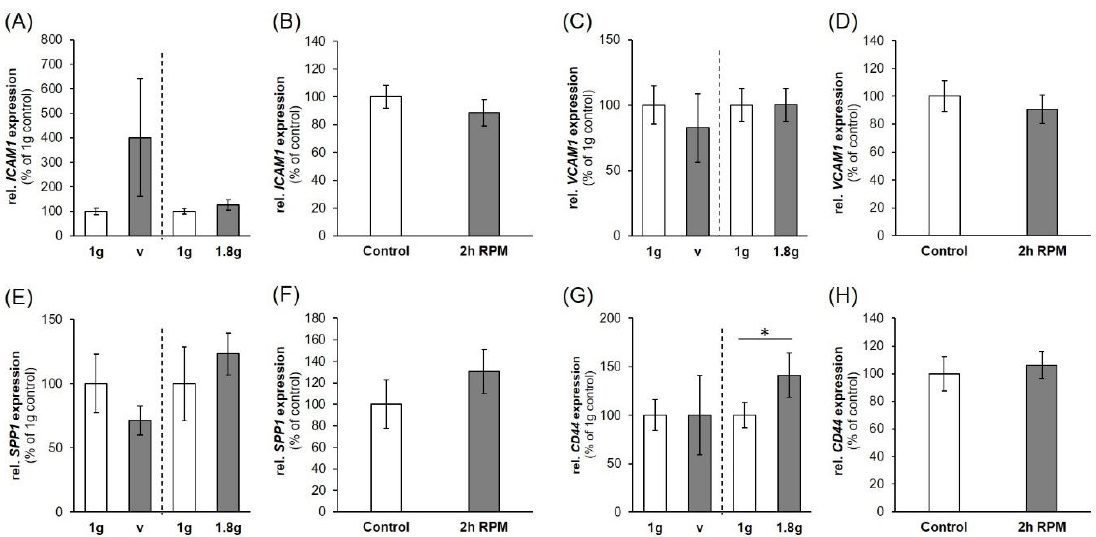
Figure 7. Influence of a VIB (V), hyper- g and iRPM-exposure on the gene expression of cell adhesion signaling factors: ( A , B ) ICAM1 , ( C , D ) VCAM1 , ( E , F ) SPP1 , ( G , H ) CD44 . 1 g : ground control; V: 2 h of vibration; 1.8 g : 2 h of hyper- g . The data are given as mean ± standard deviation. * p < 0.05 vs. 1 g -control.